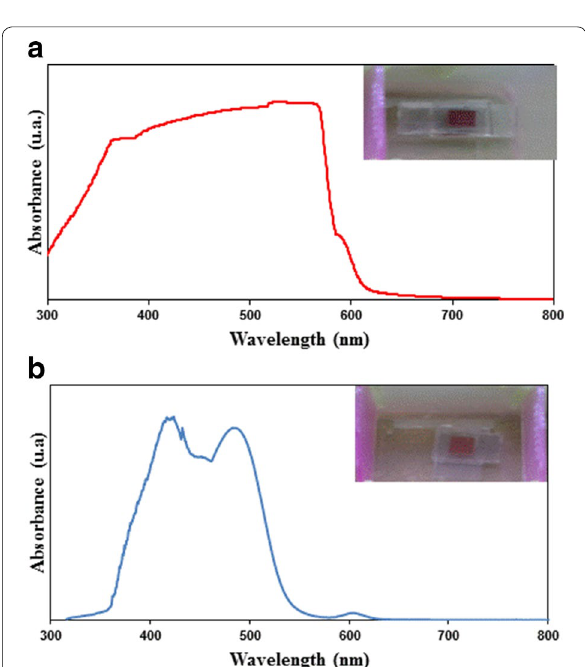
Fig. 6 Absorption spectra of a Jamaica flowers onto TiO 2 and b Mortiño fruit adsorbed onto TiO 2